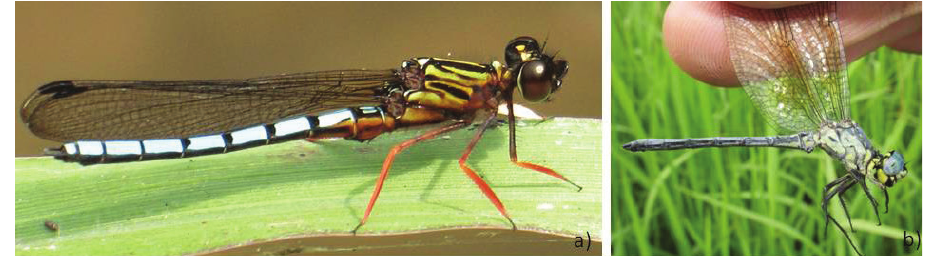
Figure 6. Photographs of Angola’s endemic a Angola Dancing Jewel ( Platycypha angolensis ) and b Angola Micmac ( Micromacromia flava ) (K.D.